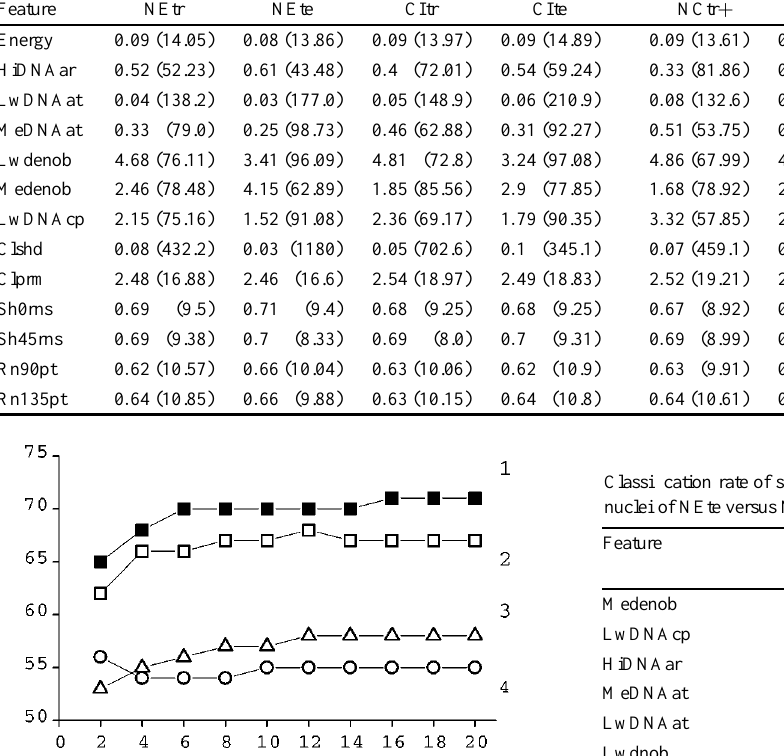
Fig. 3. Cell-by-cell classification data obtained from a discriminant function trained at the training set of normal epithelium (NEtr) ver- sus the training set of normal-appearing epithelium with dense lym- phocytic infiltrate nearby cancer (NCtr + ) (1). These functions were then applied to classification of the test sets of normal epithelium (NEte) versus normal-appearing borders of invasive laryngeal cancer with dense lymphocytic stroma infiltrate (NCte + ) (2), to NEte ver- sus normal-appearing epithelium nearby cancer of low density lym- phocytic infiltrate (NCte − ) (3) as well as to classification of NEte versus chronic inflammation (CIte) (4).